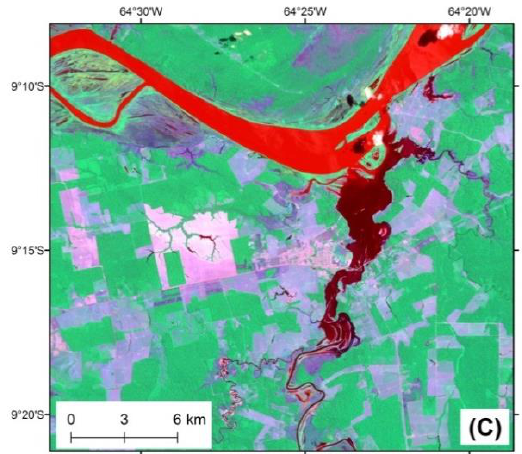
Figure 8. Portions of FNF maps produced by the TanDEM-X ( A ) and ALOS-2 ( B ) data sets over the municipality of Porto Velho, Rondônia State. TanDEM-X forest estimation = 50%; ALOS-2 forest estimation = 43%. Green color corresponds to the forest; pink color corresponds to the non-forest; white color in ( A) and blue color in ( B ) correspond to the river channel. In ( C ), the RGB color composite of Landsat 8, bands 4, 5, and 6 (overpass: 9 September, 2015) of the same region.